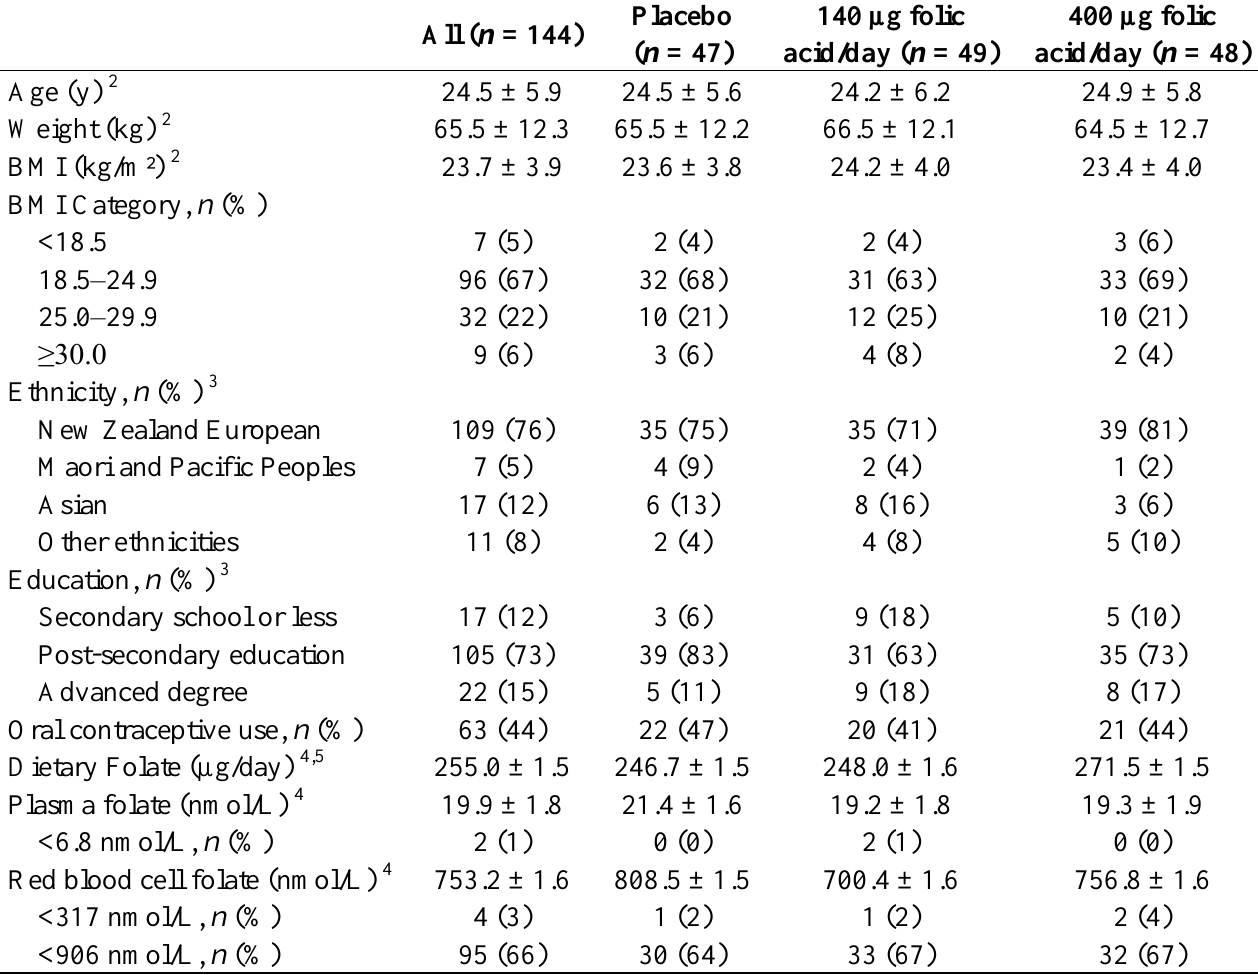
Table 1. Baseline characteristics of study population 1